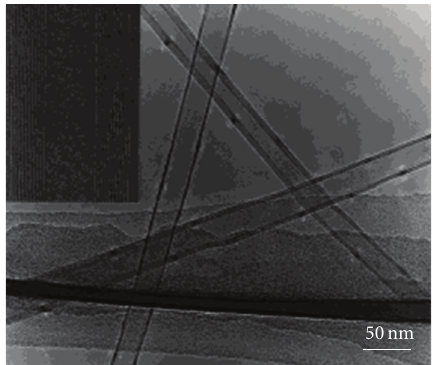
Figure 5: TEM images of BN straight cylindrical nanotubes. The inset shows the perfect ordering of BN tubular layers